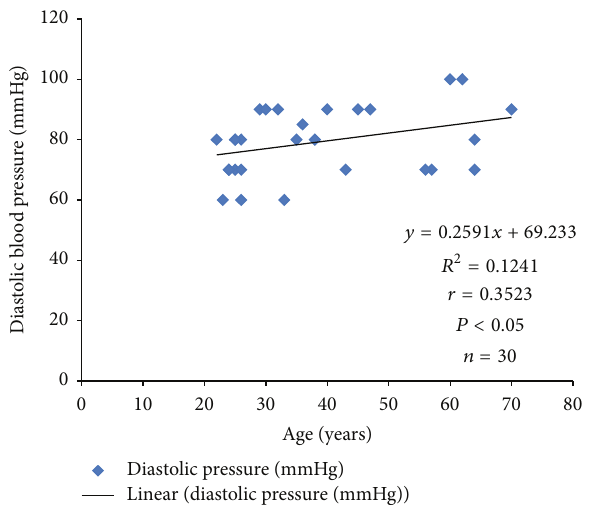
Figure 5: Correlation plot of diastolic blood pressure against age in normotensive subjects.